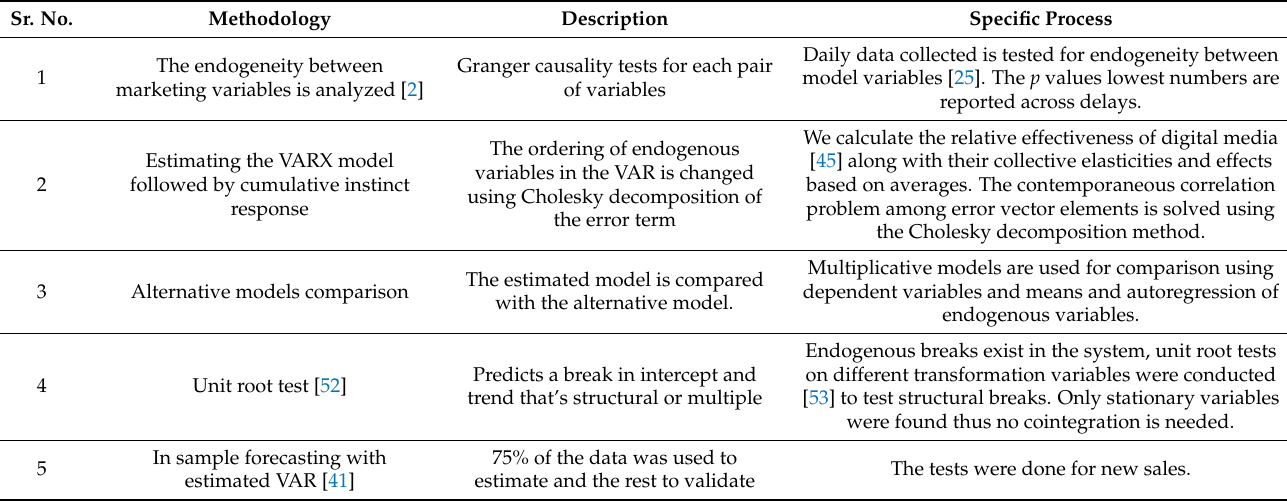
Table 2. Existing literature and variable